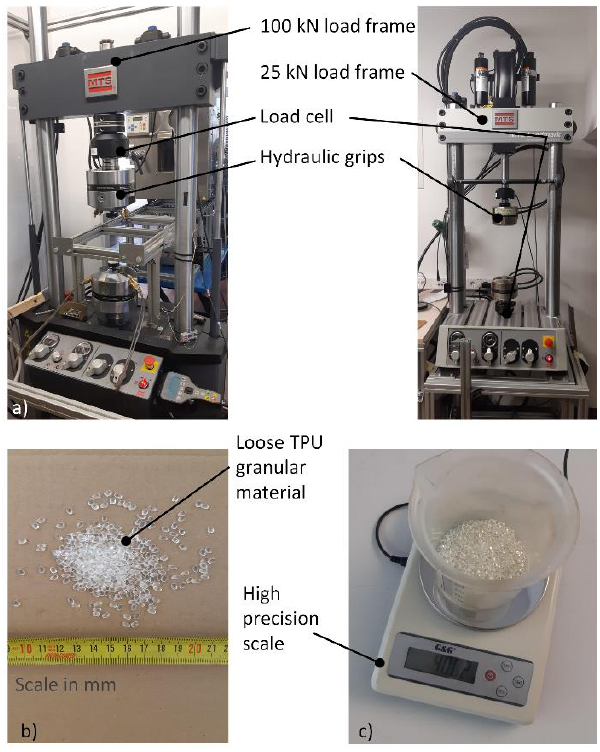
Figure 8. Experimental setup including ( a ) servo-hydraulic load frames, ( b ) TPU granular material and ( c ) a high precision scale.